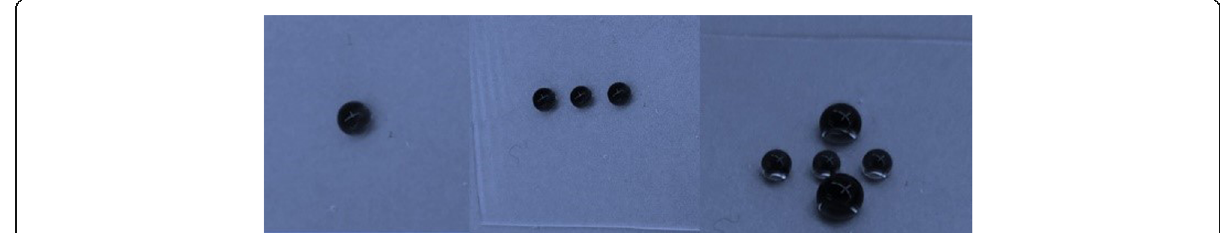
Fig. 5 Water droplets on a large surface of the superhydrophobic PDMS